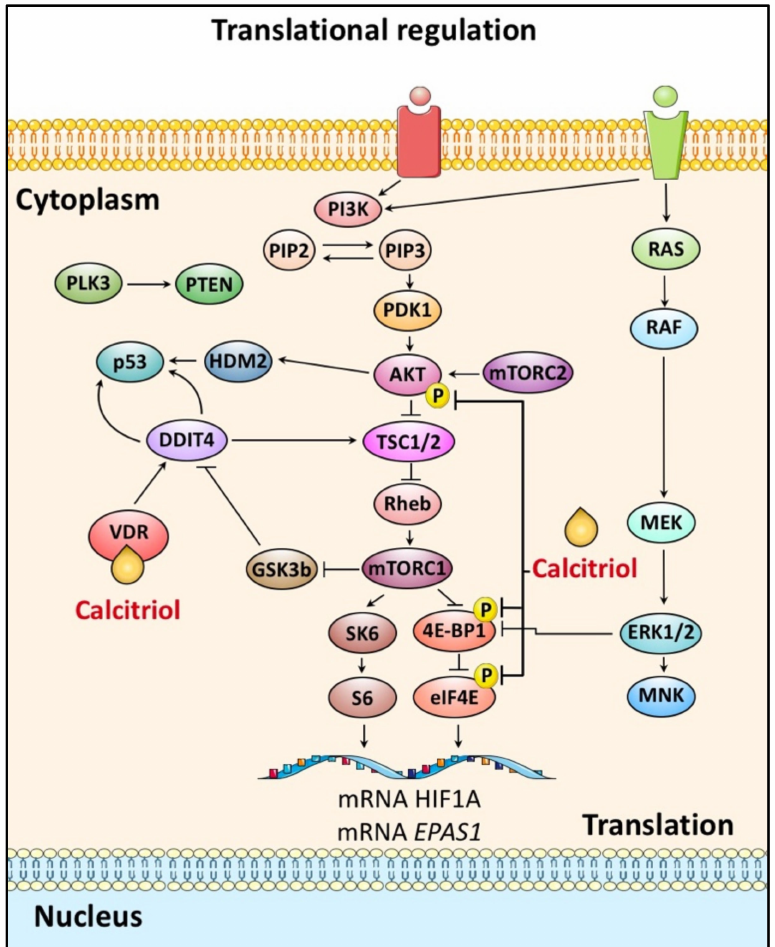
Figure 3. HIF-1/2 α subunits regulation by calcitriol at the level of their protein synthesis. HIF-1/2 α mRNA translation is mainly regulated by the PI3K/AKT pathway, which frequently cross-talks with ERKs. Calcitriol in complex with VDR enhances DDIT4 expression and impairs mTORC1-mediated translation of HIF-1/2 α . Furthermore, calcitriol treatment results in decreased phosphorylation of PI3K/AKT-pathway components and limits HIF-1/2 α translation